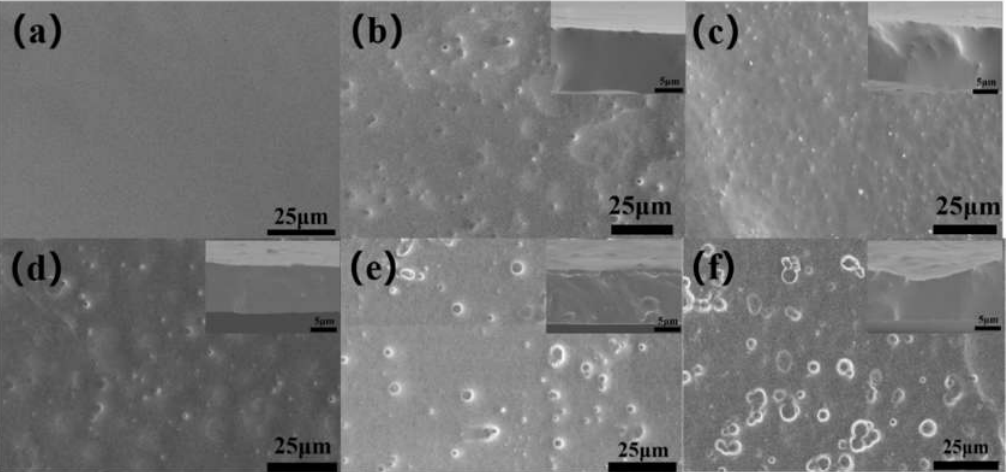
Figure 3. SEM of the surface and cross-section of the composite films with ( a ) 0 wt.% PS, ( b ) 1 wt.% 40 nm PS, ( c ) 3 wt.% 40 nm PS, ( d ) 5 wt.% 40 nm PS, ( e ) 5 wt.% 80 nm PS, ( f ) 5 wt.% 120 nm PS.